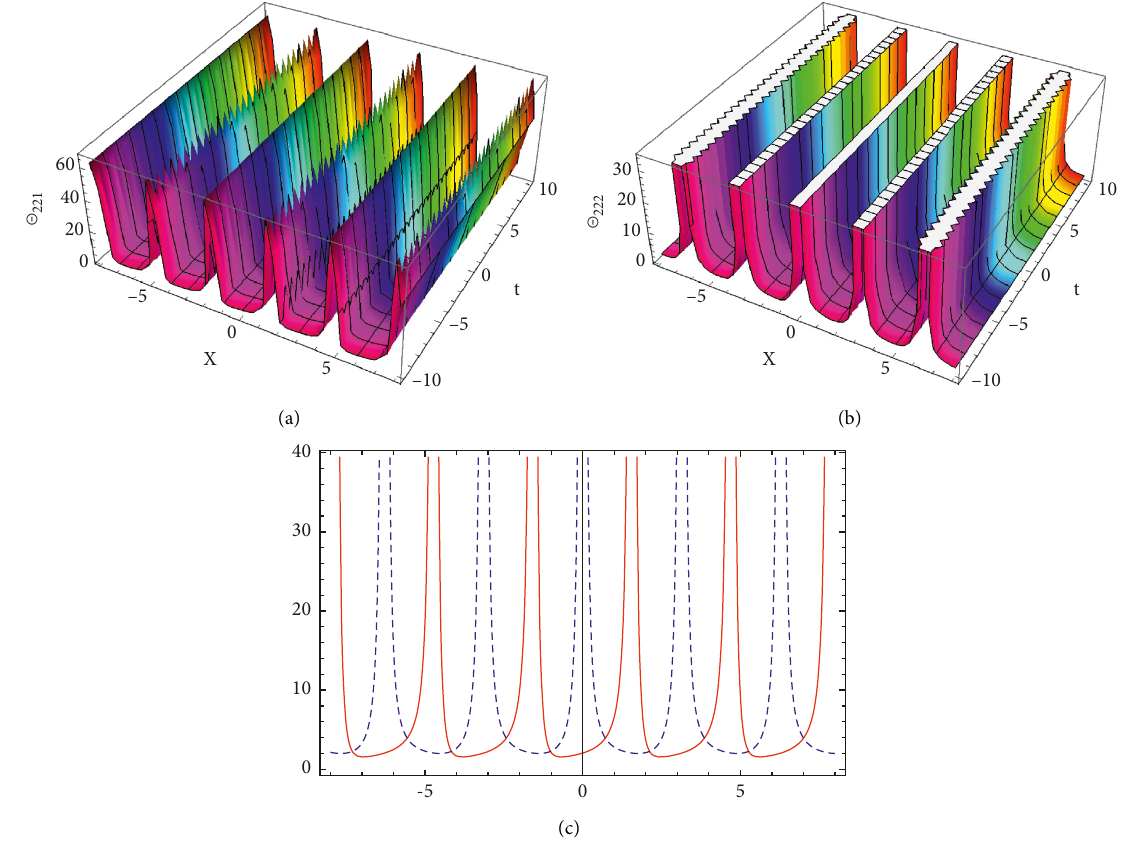
Figure 5: Plots of equations (59) and (60) for m � 2, ξ � 0 . 3, λ